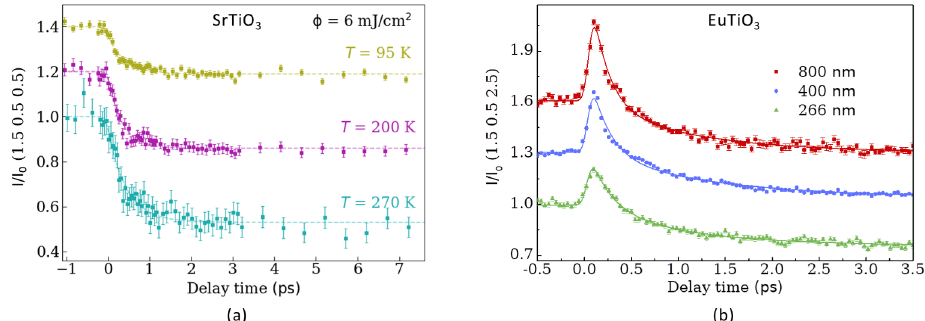
Figure 2. Ultrafast dynamics of AFD induced x-ray superlattice reflections after photoexcitiation of STO and ETO. (a) Reflection intensity of STO probed with 140 fs x-ray pulses on excitation with 100 fs pulses centered at 266 nm for a series of base temperatures. (b) Transient intensity of a similar reflection of ETO probed with 40 fs x-ray pulses for a series of excitation wavelengths at T = 110 K and excitation fluencies yielding a similar drop below the initial baseline. Curves are separated by a constant vertical o ff set for